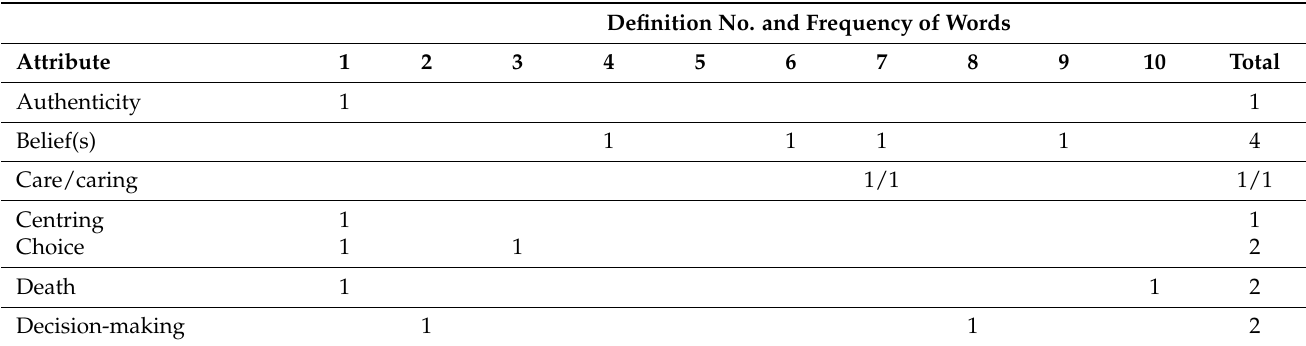
Table 3. Keywords used in definitions of